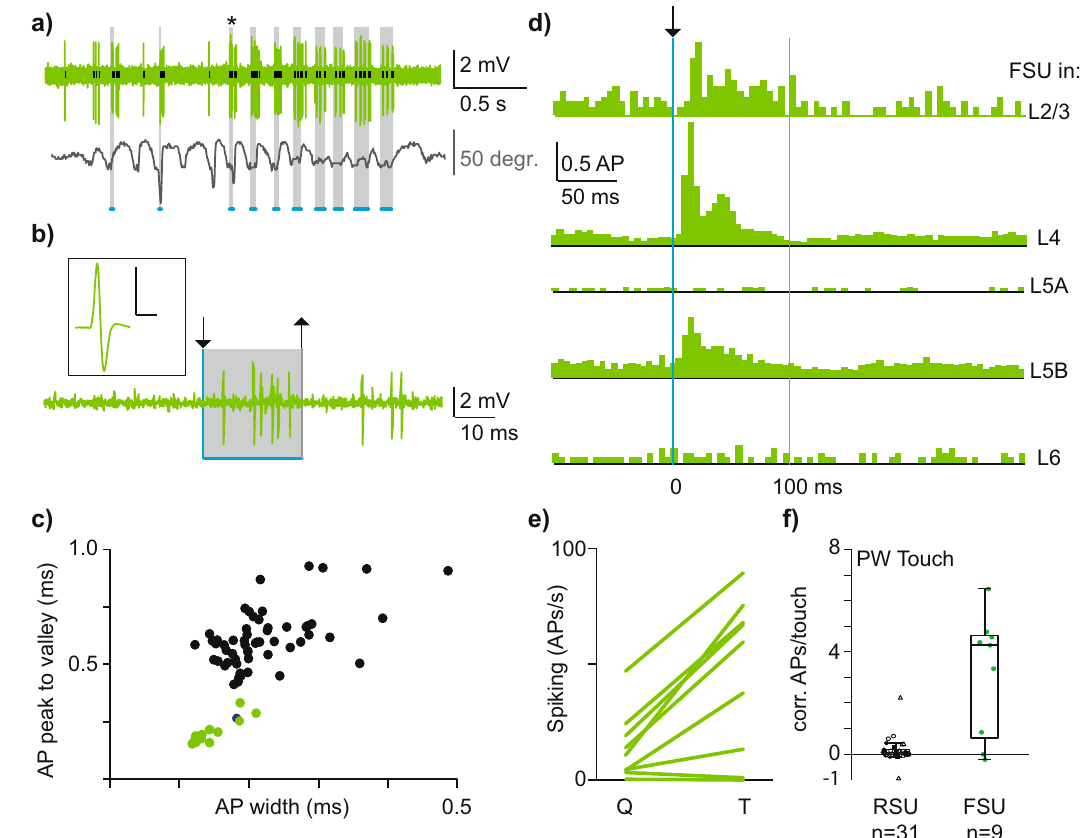
Fig. 3 Dense representation of naive object touch in fast-spiking units across layers. a Loose-patch recording of an individual fast-spiking-unit (FSU) in L4 including whisker position and naive object touch. Note robust increase in spiking upon naive object touch. b A single touch from a (with asterisk) at increased temporal resolution. The absolute touch duration is indicated with gray shading. Arrows indicate touch start and touch end, respectively. Scale bars inset: 0.5 mV, 0.5 ms. c Average waveform parameters for RSUs and FSUs across layers of PW and SuW column. FSUs in green, RSUs in black. One AP waveform (blue bullet) clustered with FSUs but morphological reconstruction revealed L5st identity and the unit was classi fi ed according to morphology. d Individual PSTHs for n = 5 example FSUs recorded across layers. e Spiking rate for PW-FSUs across behavioral states (Q = quiescent, T = touch). f Sparse versus dense coding of touch for regular versus fast-spiking units, respectively (Mann – Whitney, p < 0.01). Boxplots show median as central mark, the edges of the box the 25th and 75th percentiles, the whiskers extend to the most extreme data points, and the outliers are plotted